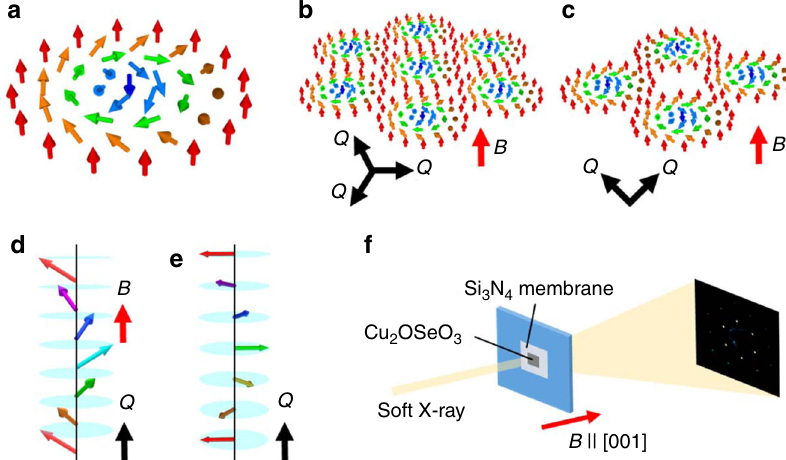
Fig. 1 Small-angle resonant soft X-ray scattering (RSXS) experiments for the detection of various spin textures. a – e Schematic illustrations of an isolated skyrmion ( a ), triangular SkL ( b ), square SkL ( c ), conical ( d ), and helical ( e ) spin textures. The directions of magnetic modulation vector Q and magnetic fi eld B are also indicated. f Experimental setup for the small-angle RSXS measurements (see “ Methods ”